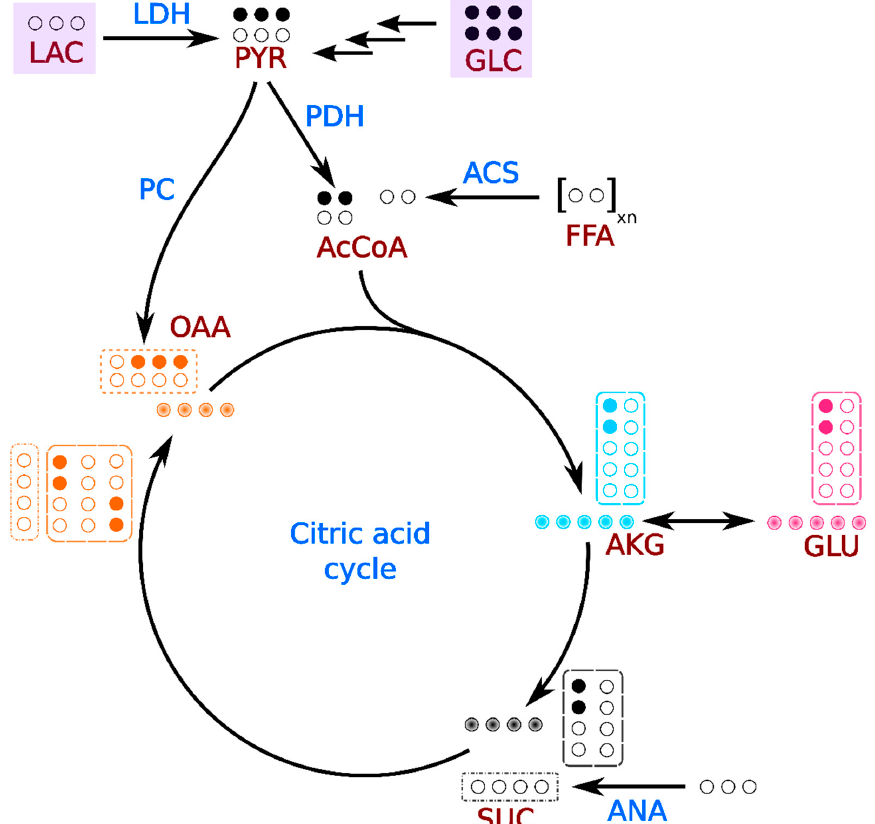
Figure 4. Pathway diagram showing the propagation of 13 C label through citric acid cycle and anaplerotic intermediates. Solid-filled circles represent 13 C label and gradient-filled circles represent all possible isotopomers for each metabolite. Isotopomers generated in the first turn of citric acid cycle and anaplerotic fluxes are indicated by dashed and dot-dashed boxes respectively. Carbons are numbered in right-to-left and bottom-to-top directions. Multiple arrows indicate multi-step